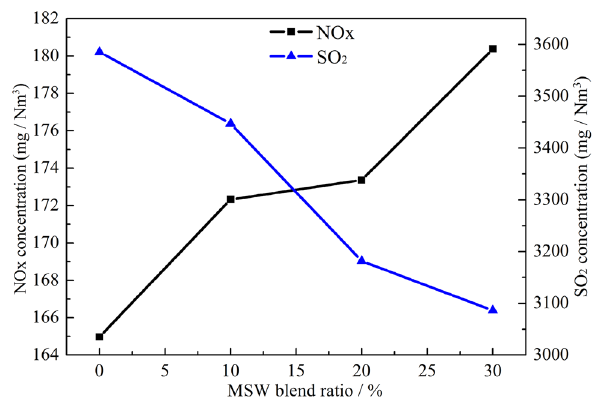
Fig. 6 Effect of MSW blend ratio on the NO x and SO 2 emissions